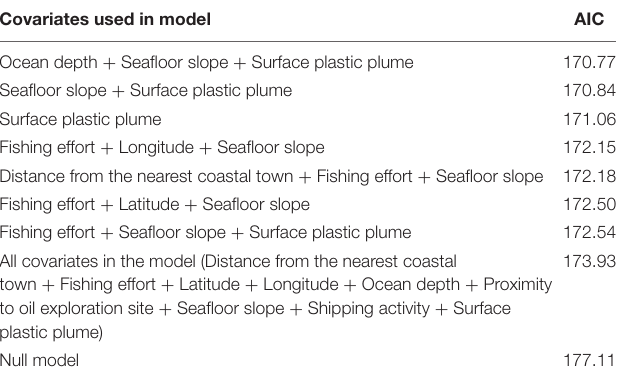
TABLE 2 | The best fit GAM (based on the lowest AIC value) for investigating potential explanatory variable effects on MP